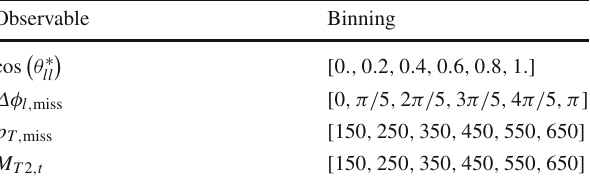
Table4 Binningofthedifferentialdistributionsusedforthecalculation of signal strength exclusion